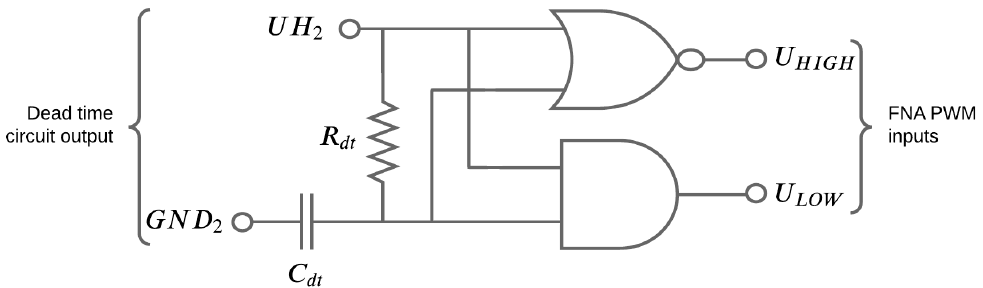
Figure 4. Circuit to generate the complementary PWM and dead-time signals